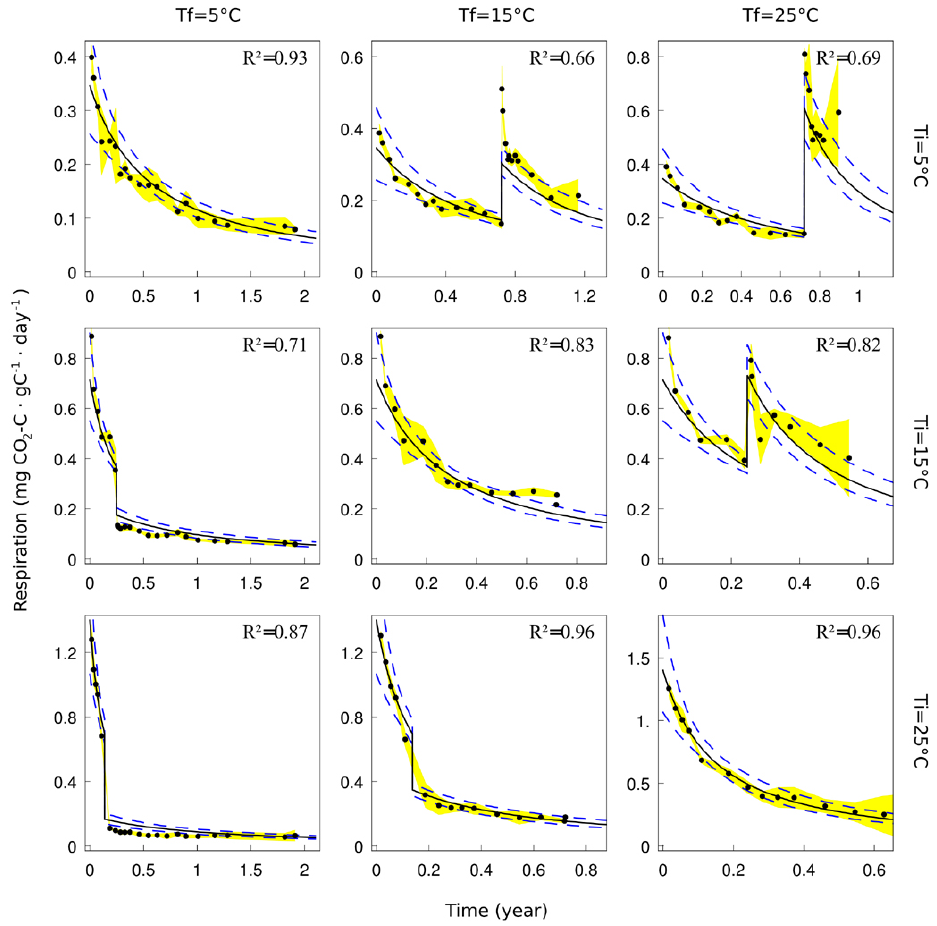
Fig. 1. Model predictions of respiration rates for the one initial quality, fixed decomposer efficiency model and observed respiration rates for all combinations of initial ( T i ) and final ( T f ) temperatures (5 ◦ C, 15 ◦ C, and 25 ◦ C.) Weighted ensemble run predictions (solid black line) with max/min curves (blue dashed lines) for the behavioural parameter sets. The yellow fields show 95% error bounds around measured data points (dots). Least square R 2 -values are shown in top right corner of each